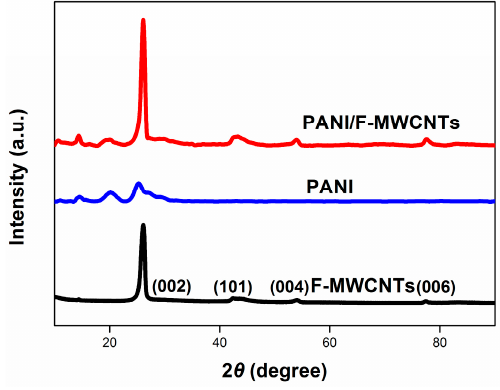
Figure 2. XRD patterns of PANI/F-MWCNTs, PANI, and F-MWCNTs.